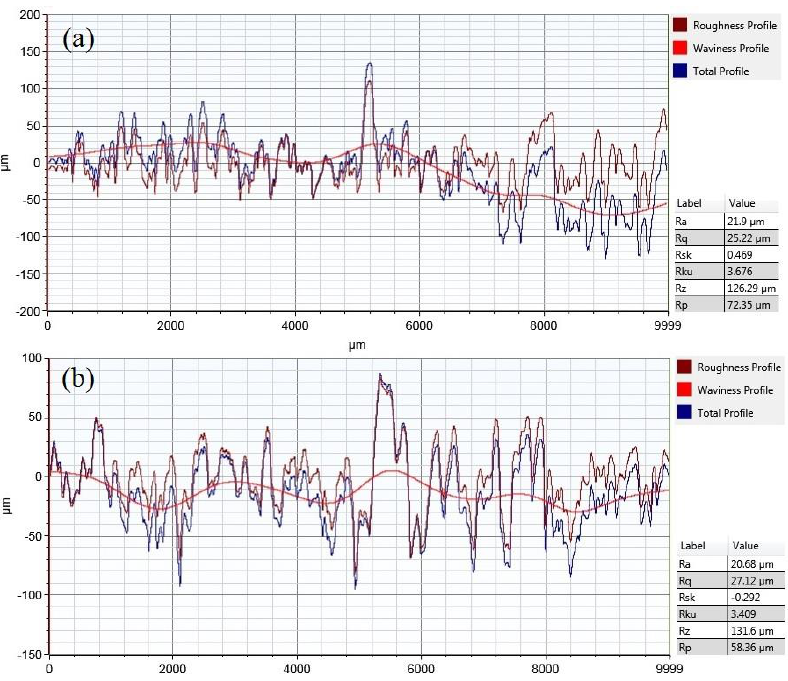
Figure 13. Surface roughness profiles: ( a ) minimum support removal time; ( b ) maximum support removal time.